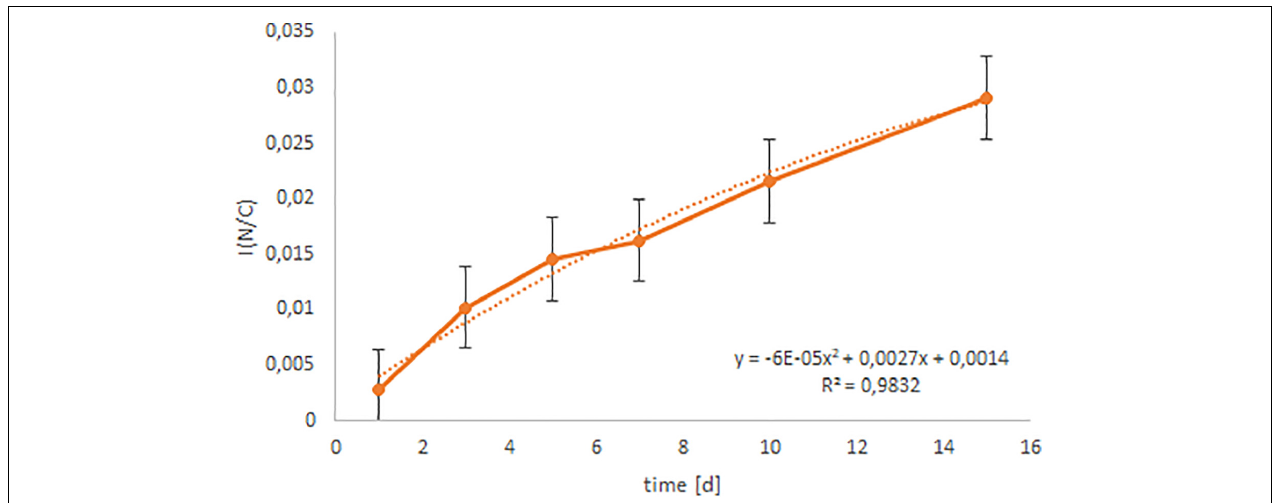
FIGURE 5 | Correlation analysis between N uptake of NH 4 + and time. The continuous line represents the generated data of this study, whereas the dotted line represents the ideally calculated trend